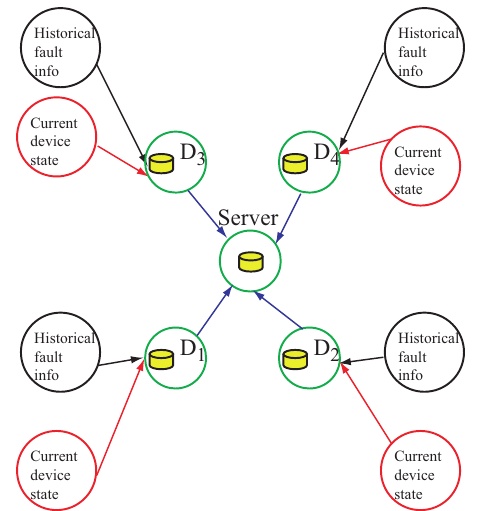
Figure 1. Big data and knowledge graph based fault diagnosis framework for the electric power